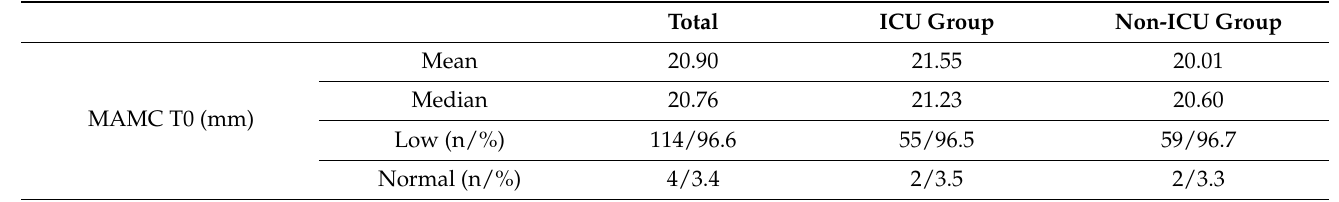
Table 4. Characterization of subjects and respective results from Mid-Arm Muscle